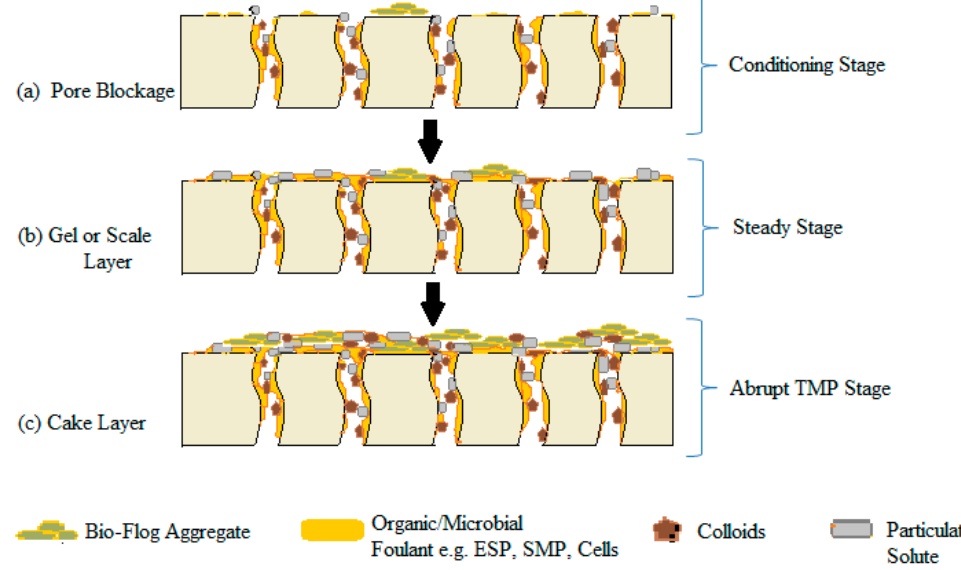
Figure 8. ( a – c ) Schematic showing mechanism of ( a ) conditioning stage, ( b ) steady stage, and ( c ) abrupt TMP stage.